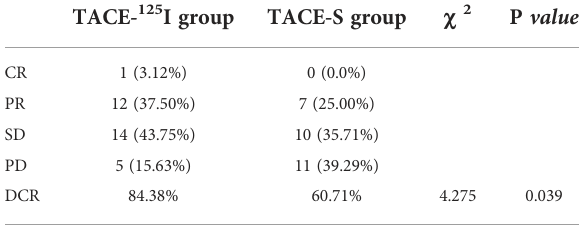
TABLE 4 Ef fi cacy assessment for intrahepatic lesions.